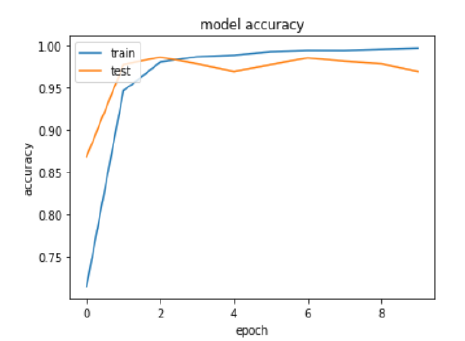
Figure 4. Training and Validation Loss.